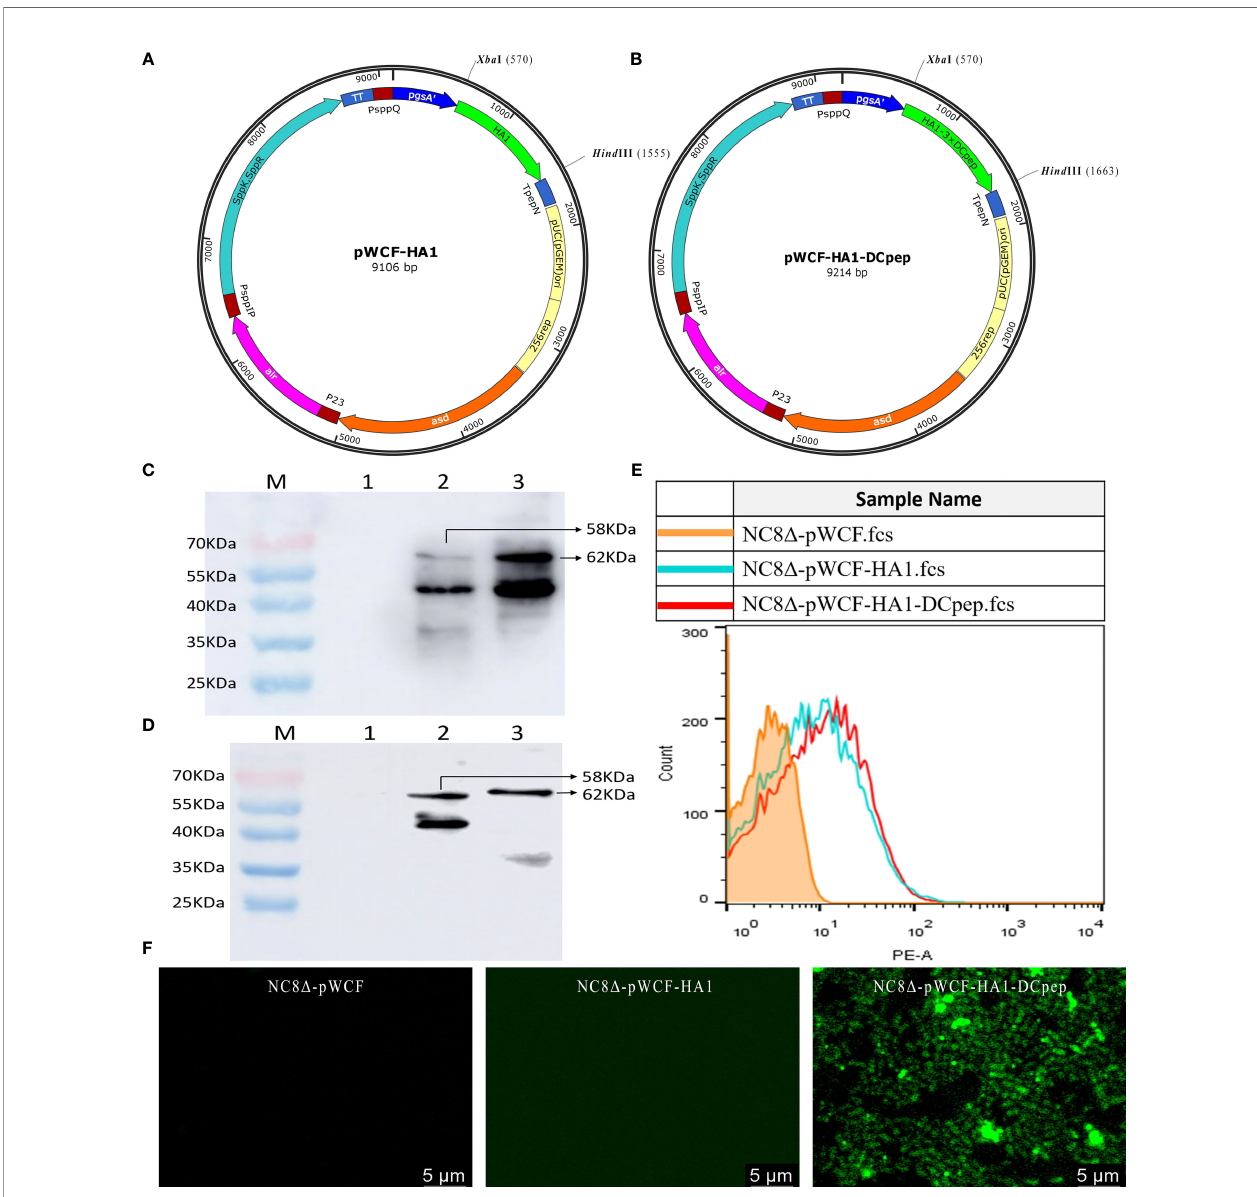
FIGURE 1 | Synthesis of pWCF-HA1 and pWCF-HA1-DCpep on L. plantarum. (A) Recombinan pWCF-HA1 plasmid mapping. (B) Plasmid pro fi le of recombinant pWCF-HA1-DCpep. (C) Recombinant bacteria were sonicated, and the synthesis of fusion antigens was detected by immunoblotting using an anti-H7N9 hemagglutinin antibody. M: marker; Lane 1: NC8 D -pWCF; Lane 2: NC8 D -pWCF-HA1; Lane 3: NC8 D -pWCF-HA1-DCpep. (D) Recombinant L. plantarum were subjected to repeated freeze-thaw cycles, and fusion antigen synthesis was detected by immunoblotting using an anti-H7N9 hemagglutinin antibody M: marker; Lane 1: NC8 D -pWCF; Lane 2: NC8 D -pWCF-HA1; Lane 3: NC8 D -pWCF-HA1-DCpep. (E) Flow cytometry with an anti-H7N9 hemagglutinin antibody and PE- conjugated anti-mouse IgG antibody. (F) Indirect immuno fl uorescence analysis with an anti-DCpep antibody followed by indirect immuno fl uorescence analysis with a FITC-conjugated anti-mouse IgG